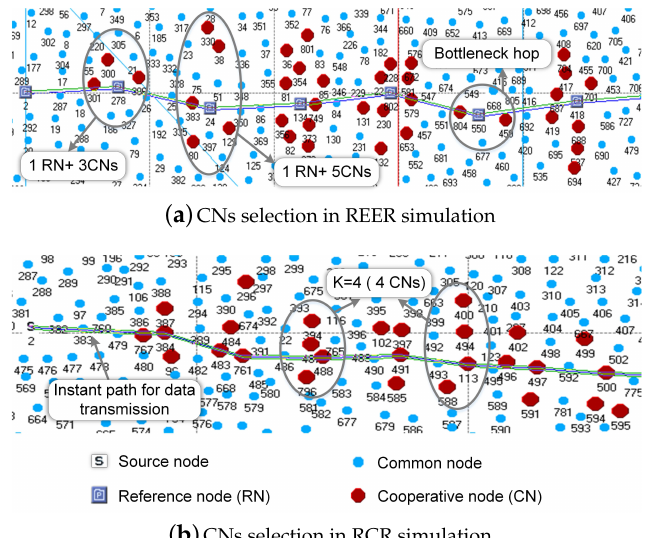
Figure 10. CNs select in